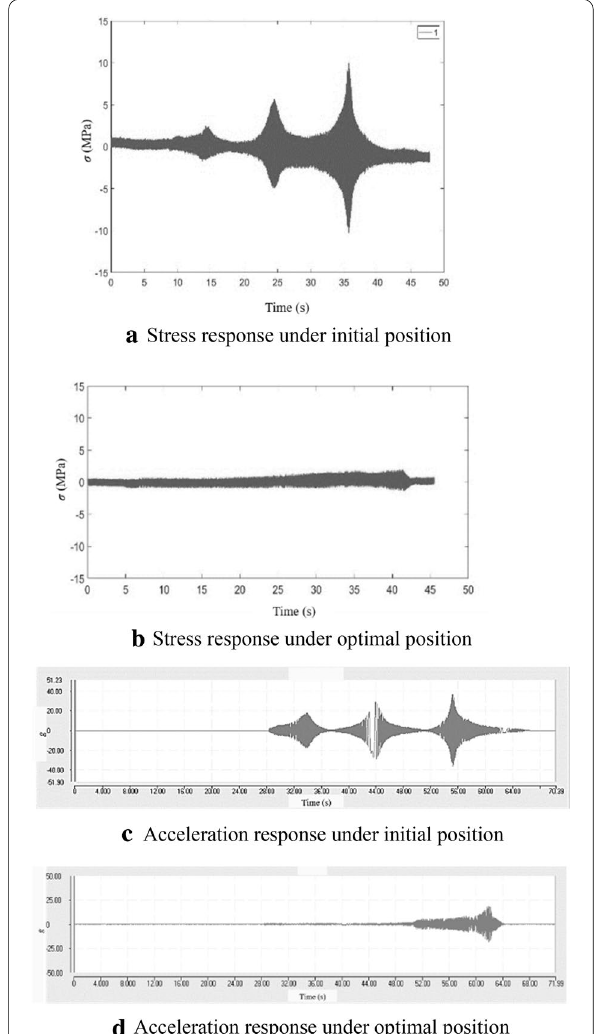
Figure 15 Dynamic responses under frequency sweep. a Stress response under initial position. b Stress response under optimal position. c Acceleration response under initial position. d Acceleration response under optimal position